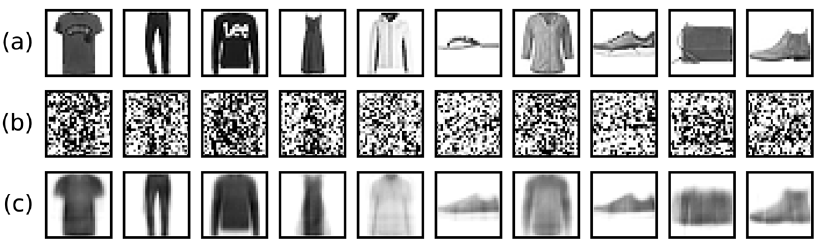
Fig. 3 Example images for the denoising task. Row a contains original images from the Fashion-MNIST dataset. Row b shows the same images with additional Gaussian noise. These noisy images serve as input data for the trained system. Row c shows the obtained reconstructions of the original